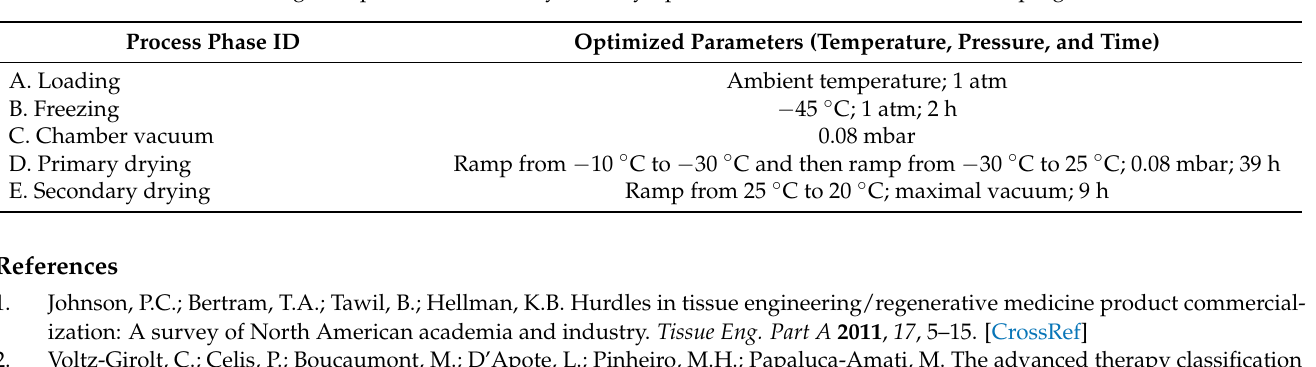
Table A3. Optimized lyophilization cycle parameters (i.e., fluid temperature, chamber pressure, step duration) for